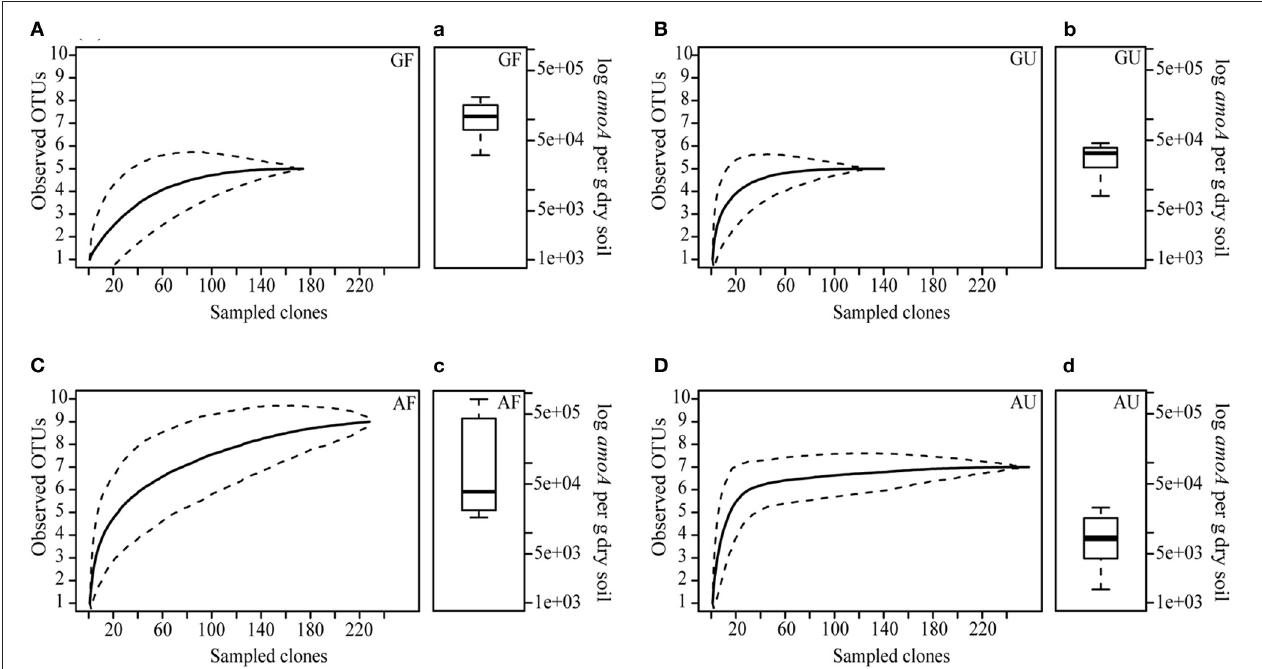
FIGURE 2 | Rarefaction curves for archaeal amoA clone libraries (A–D) as well as boxplots of archaeal amoA gene abundances (a–d) from the four different soil groups ( n = 3 or 4). (A–D) Shown are average numbers of observed OTUs defined at 15% nucleotide sequence dissimilarity (solid line) as well as the lower and upper 95% confidence intervals (dotted lines). OTUs